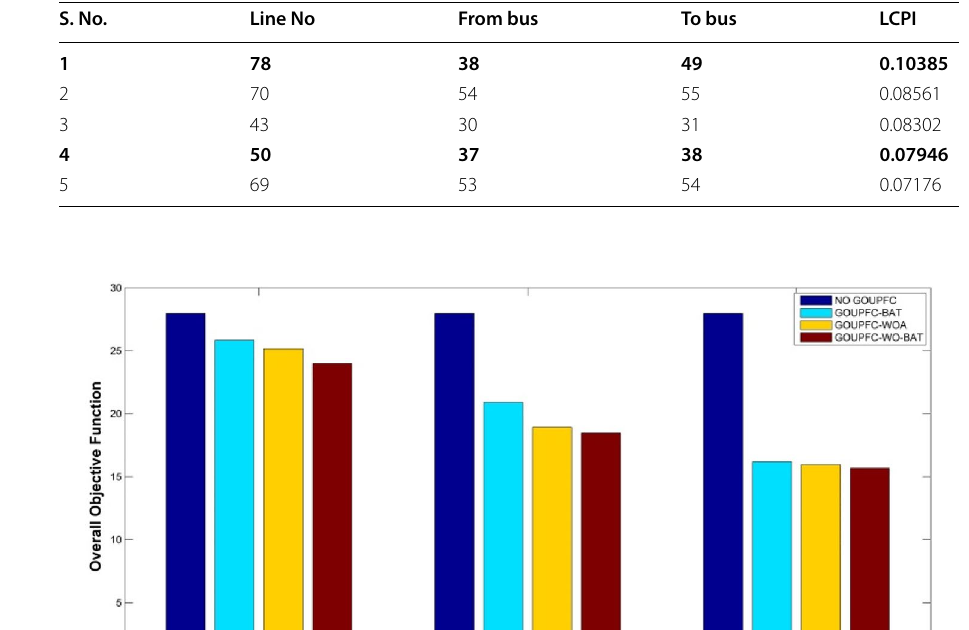
Table 1 Optimal location of GOUPFC based on LCPI S. No.